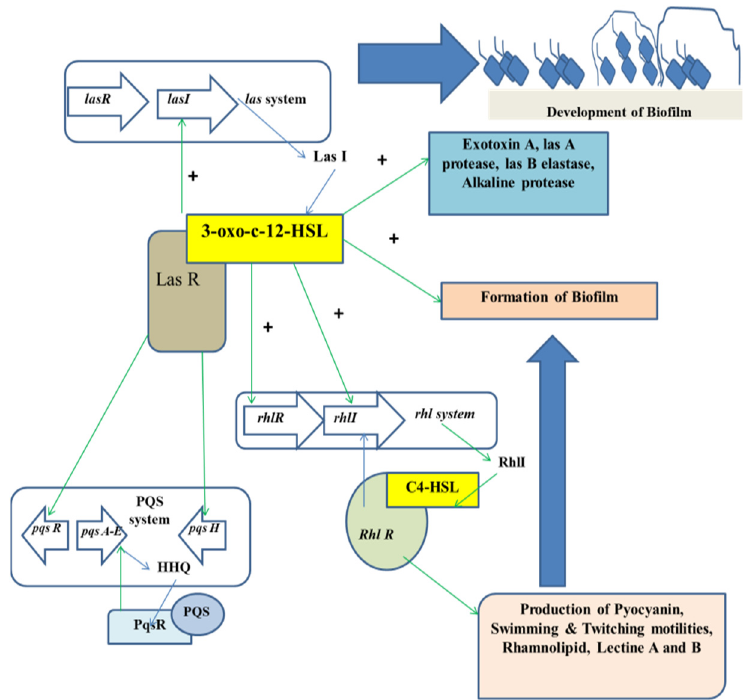
Figure 1. Regulation of QS in the development of biofilm.